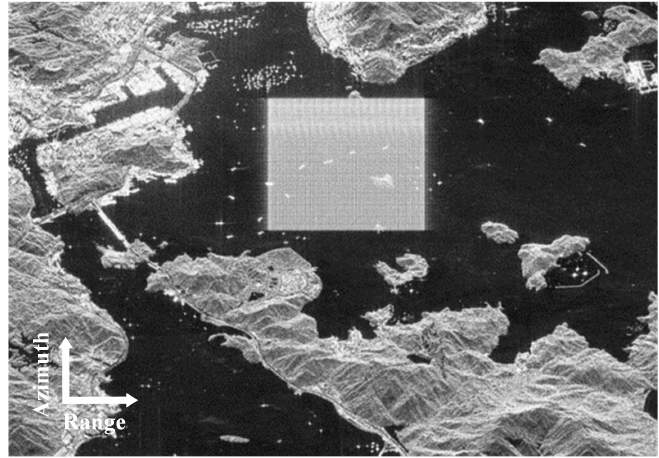
Figure 8. Jamming result of the LFM